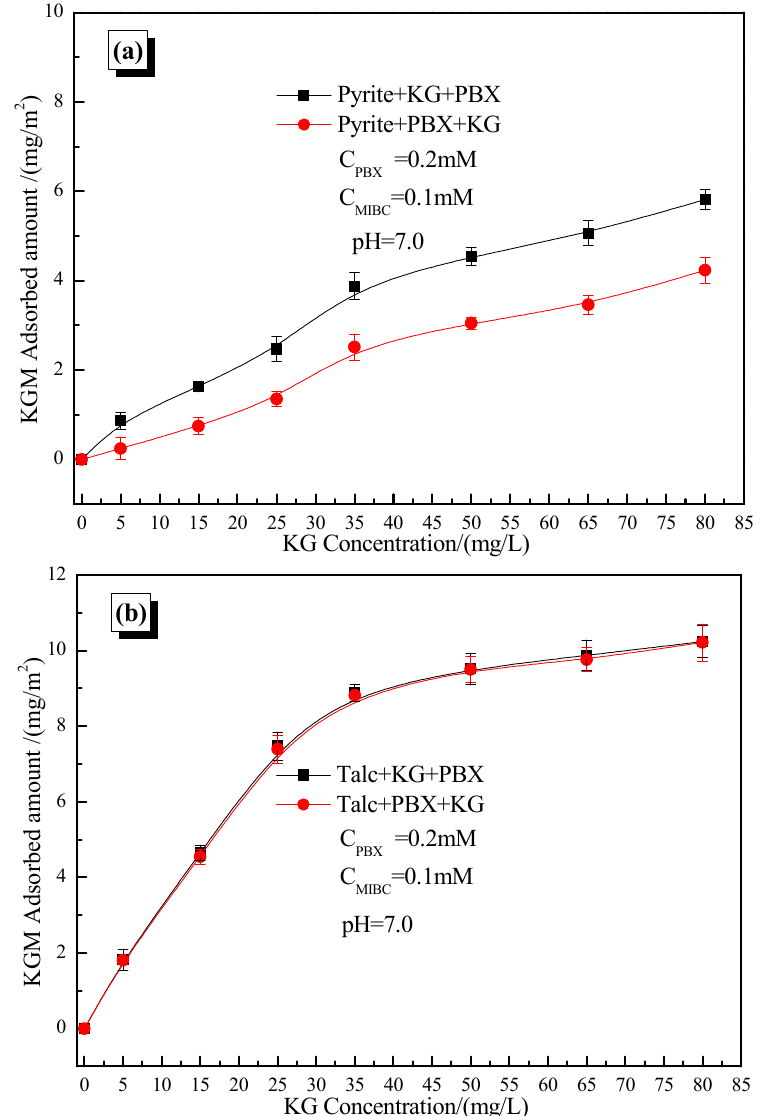
Figure 9. Effect of the KG/PBX addition order on the adsorption of KG on pyrite ( a ) and talc ( b ).